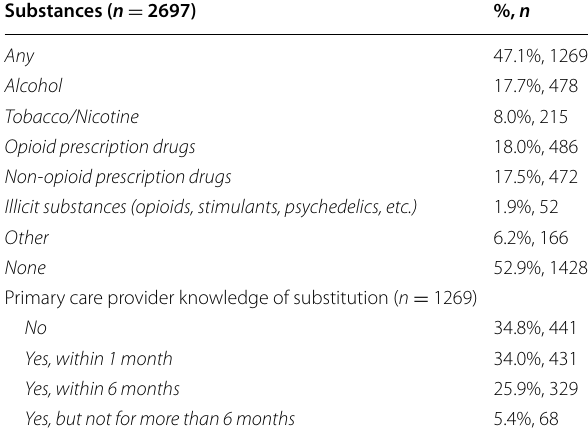
Table 3 Substitution of cannabis for other substances